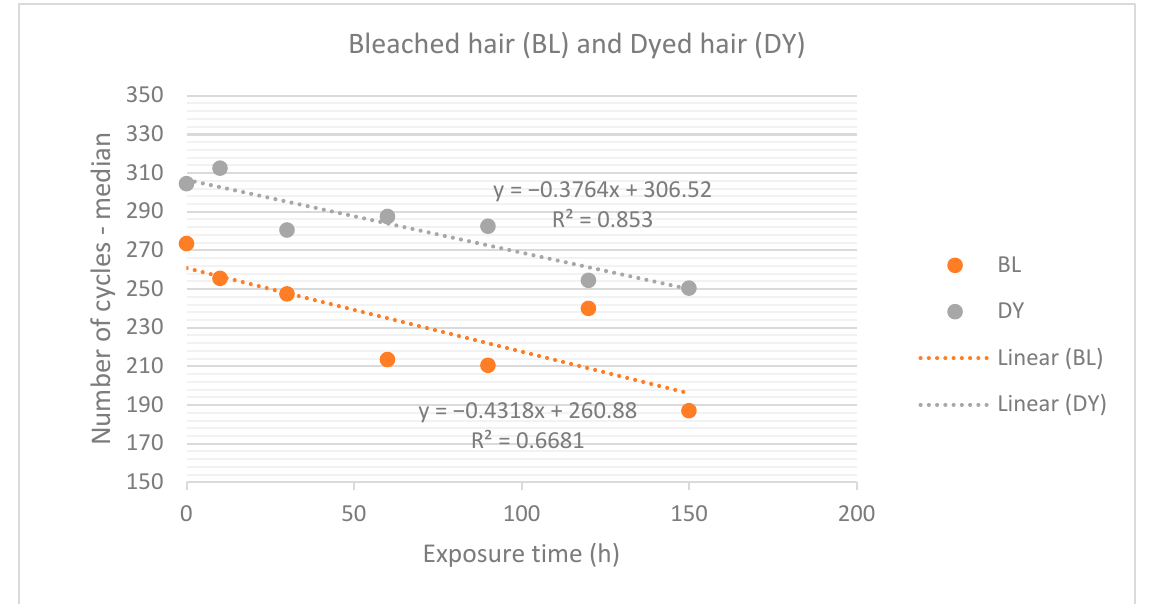
Figure 4. Linear regression of the data obtained for the bleached and dyed hair groups.